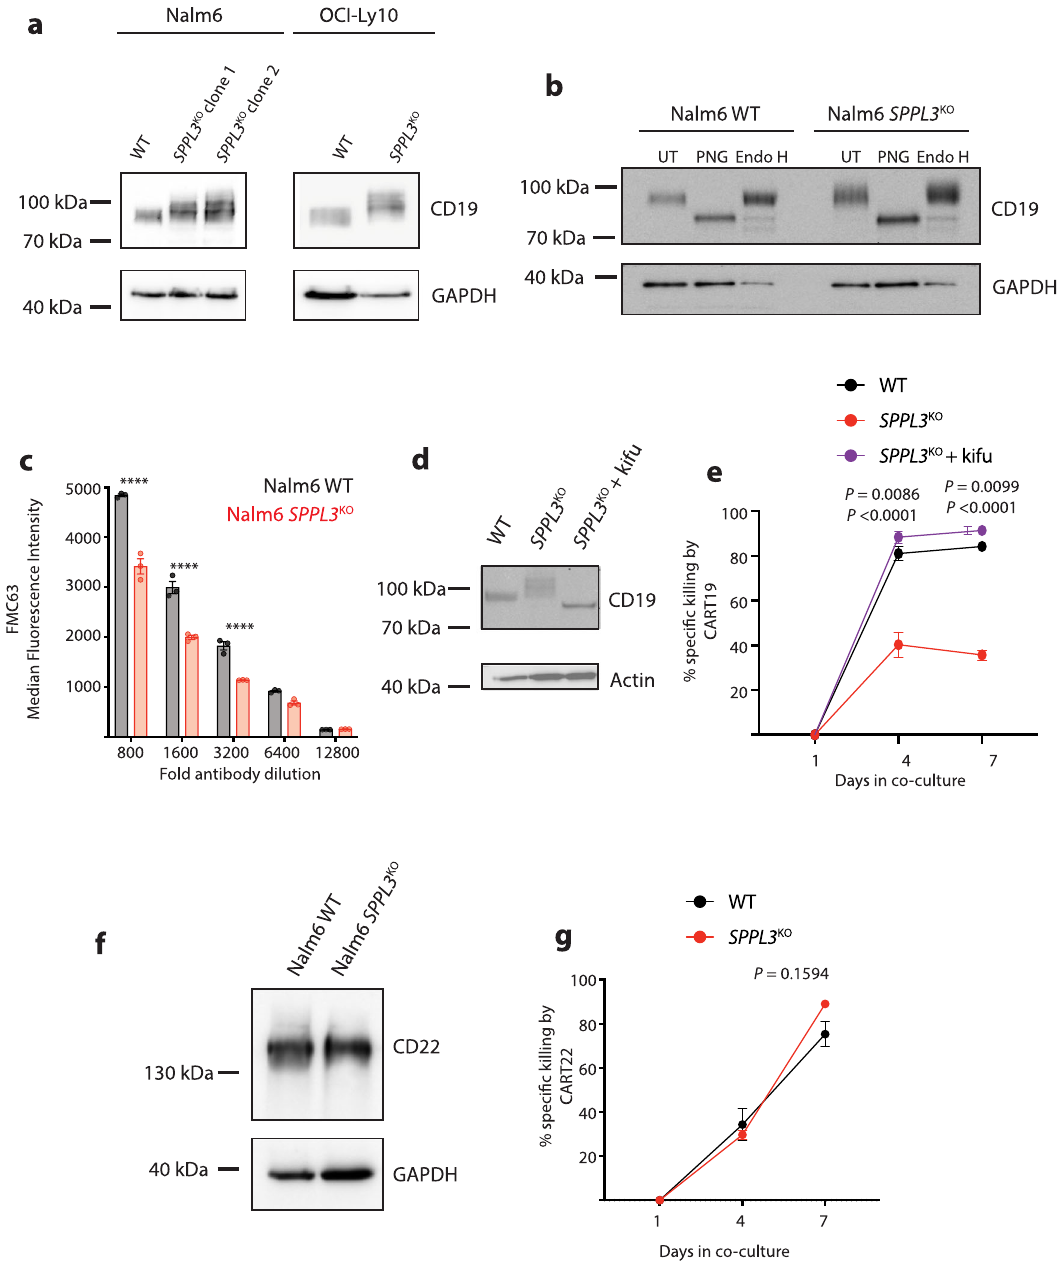
Fig. 3 Hyperglycosylation impairs detection of CD19. a Western blot of lysates from WT or SPPL3 KO Nalm6 and OCI-Ly10 cells probed for CD19. Protein electrophoresis was performed on a 6% polyacrylamide gel. Representative of n = 4 individual experiments. b Western blot of lysates from WT or SPPL3 KO Nalm6 cells that were either untreated (UT), treated with PNGase F (PNG), or treated with Endoglycosidase H (Endo H) and then probed for CD19. Representative data of n = 3 individual experiments. Electrophoresis performed on a 6% polyacrylamide gel. c Median Fluorescence Intensity of CD19 as detected by FMC63-APC on the surface of WT or SPPL3 KO Nalm6 cells. d Western blot analysis of lysates from cells treated with kifunensine (16 ng/mL) for 10 days and then probed for CD19. Representative of n = 2 individual experiments. e Survival of WT, untreated SPPL3 KO , and kifunensine-treated SPPL3 KO Nalm6 over time in co-culture with CART19 cells (E:T ratio 0.25:1) statistical annotations re fl ect differences between SPPL3 KO + kifu and WT and SPPL3 KO + k fi u and SPPL3 KO (lower). f Western blot of lysates from WT or SPPL3 KO Nalm6 cells probed for CD22. Representative of n = 4 individual experiments. g Survival of WT or SPPL3 KO Nalm6 cells over time after combination with CART22 (E:T ratio 0.25:1). e , g Representative data from n = 3 individual experiments with distinct donor T cells. Error bars re fl ect mean ± standard error of the mean (s.e.m.). * P < 0.05, ** P < 0.01, *** P < 0.001, **** P < 0.0001 by two-way ANOVA with Bonferroni correction for multiple comparisons. Source Data are provided as a Source Data fi